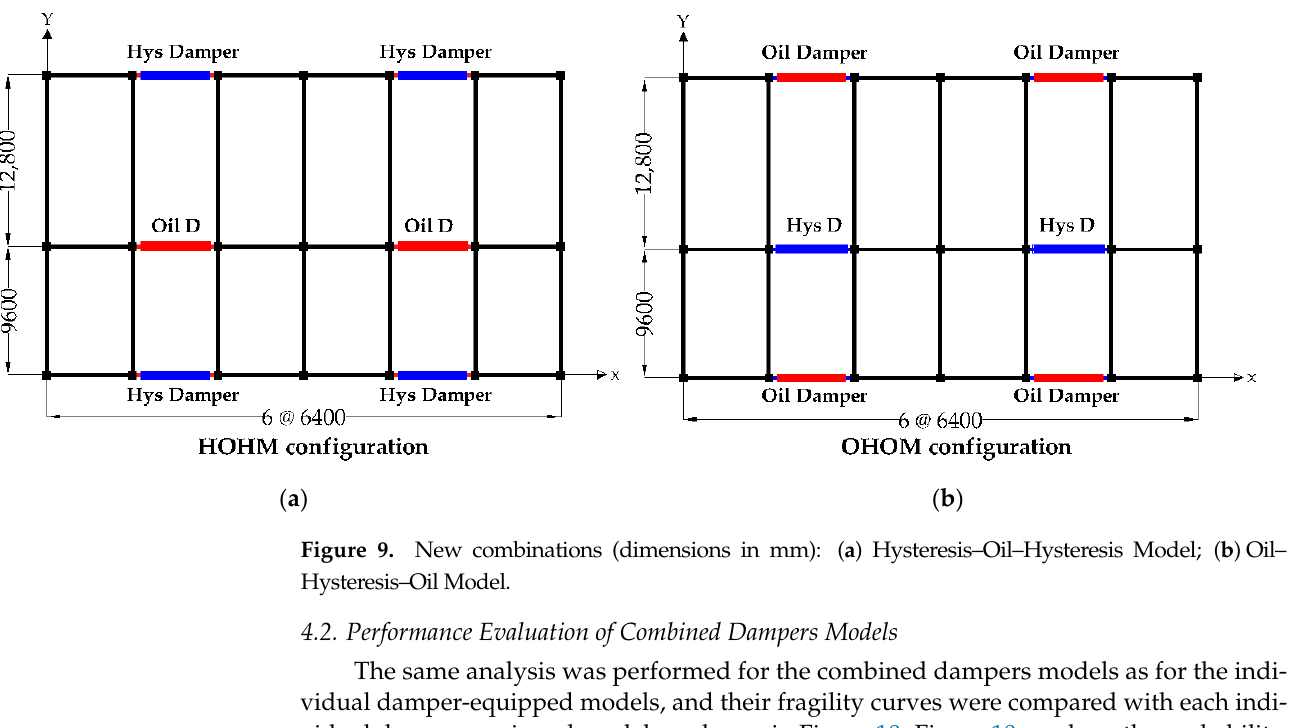
Figure 8. Energy response of hysteresis and oil dampers for TS models.